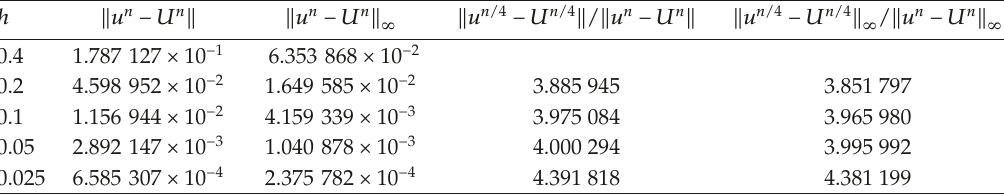
Figure 1: Exact solutions of u (cid:5) x,t (cid:6) at t (cid:7) 0 and numerical solutions computed by scheme (cid:5) 2.3 (cid:6) – (cid:5) 2.5 (cid:6) at t (cid:7) 30 , 60 for p (cid:7) 2. Table 3: The errors of numerical solutions at t (cid:7) 60 with τ (cid:7) h for p (cid:7) 6.